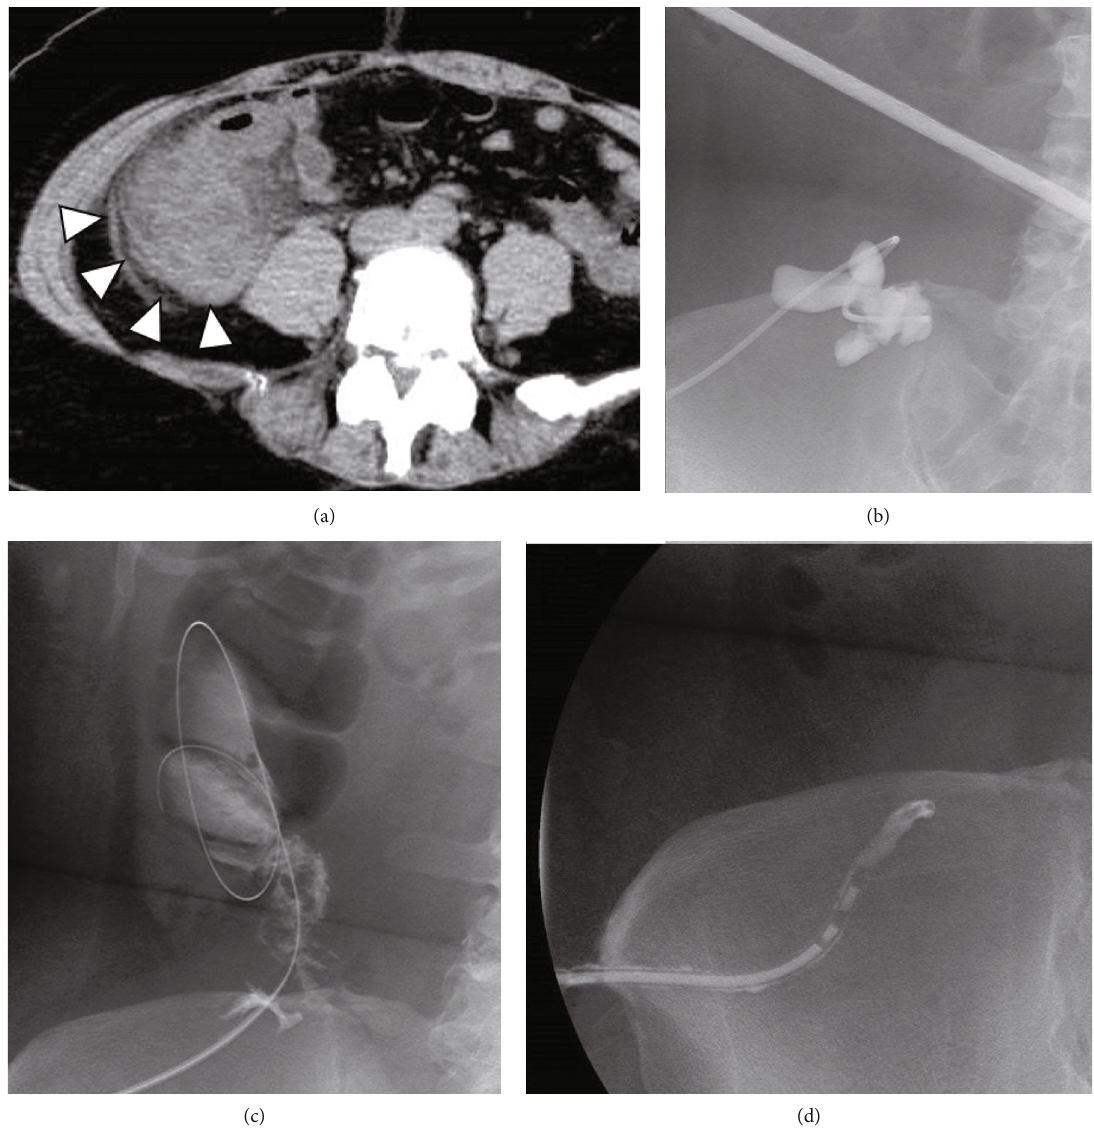
Figure 4: Case 4 fi ndings. (a) CT showed abscess formation by penetration of terminal ileum diverticulitis (arrowheads). (b) Fluoroscopy examination showed the abscess puncture and drainage using 7Fr PTC Drainage tube (Pigtail type, CREATE MEDIC CO., LTD., Japan) were performed. At this time, the ileum and cecum were not visualized. (c) Fluoroscopy examination showed the presence of guidewire and drainage tube inside the cecum through the terminal ileum after 5 days of drainage. (d) Fistography examination using a drainage tube did not show terminal ileum after 13